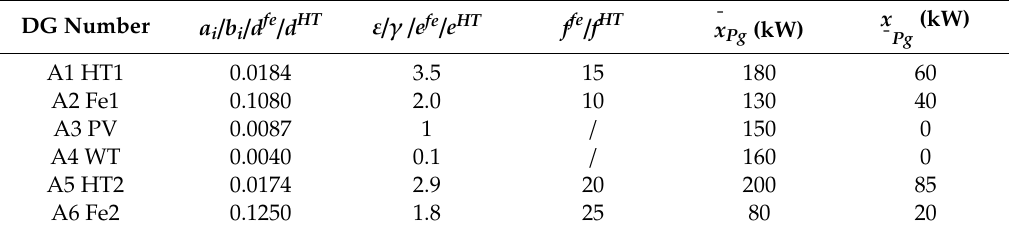
Figure 7. The communication topology of Distributed Generators (DGs). Table 1. Simulation